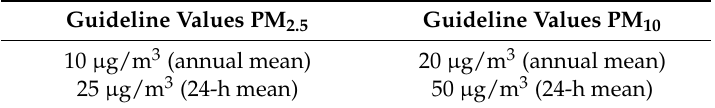
Table 1. Guideline values of exposure to PM 2.5 and PM 10 by World Health Organization (WHO